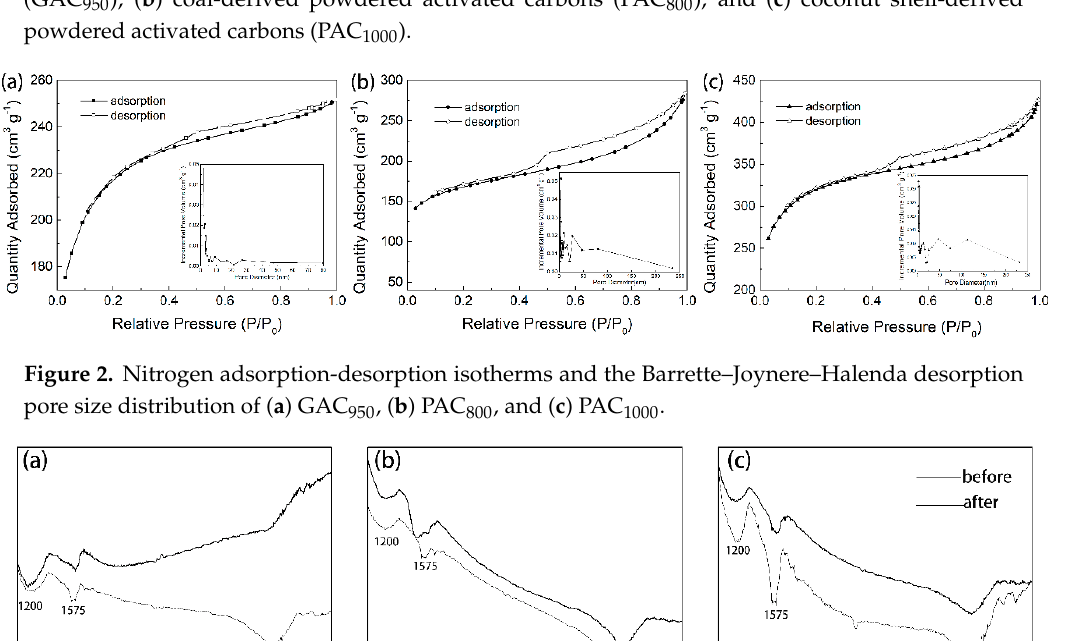
Figure 1. Scanning electron microscope (SEM) images of ( a ) coal-derived granular activated carbons (GAC 950 ), ( b ) coal-derived powdered activated carbons (PAC 800 ), and ( c ) coconut shell-derived